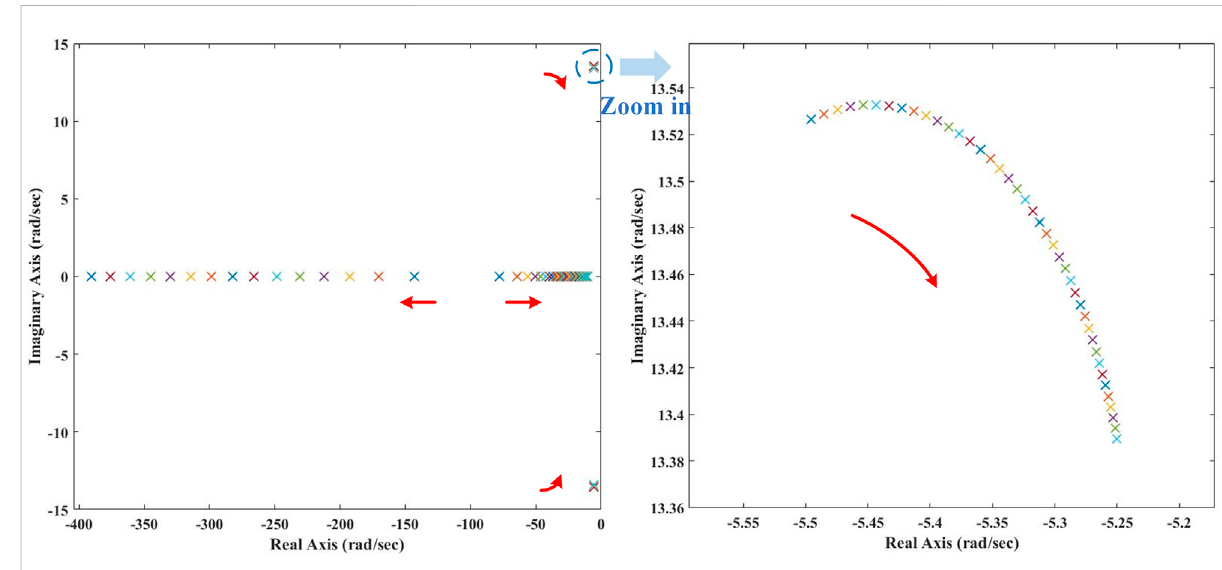
FIGURE 6 Root locus diagram. (A) K p * , im (cid:2) K p * , ij change from 1 to 5. (B) Partially enlarged diagram.